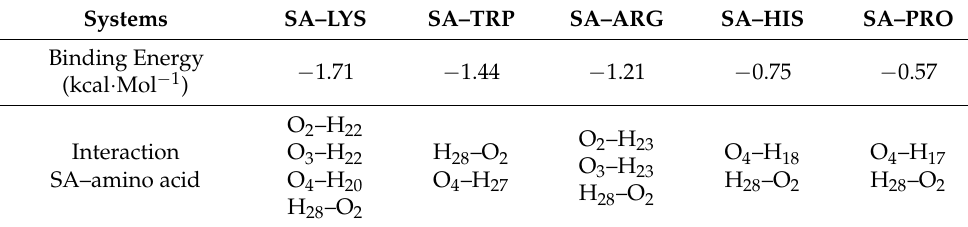
Table 1. Summarized values of the binding energy for generated systems and possible interaction points between SA and amino